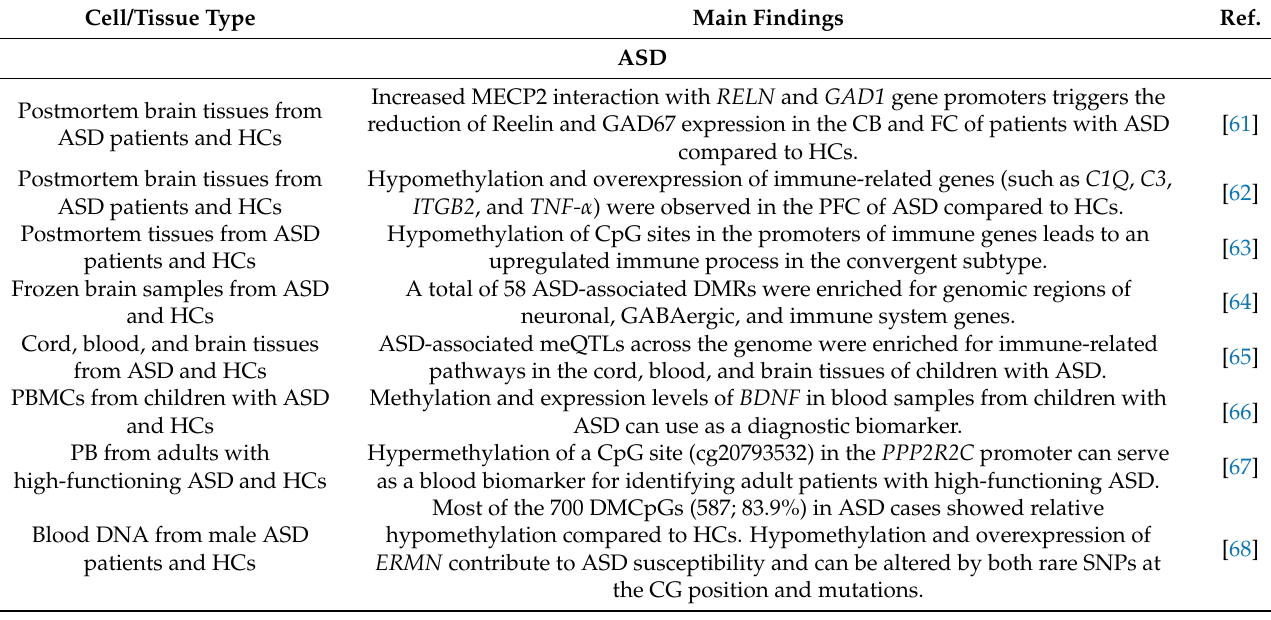
Table 2. Potential DNA methylation markers in autism spectrum